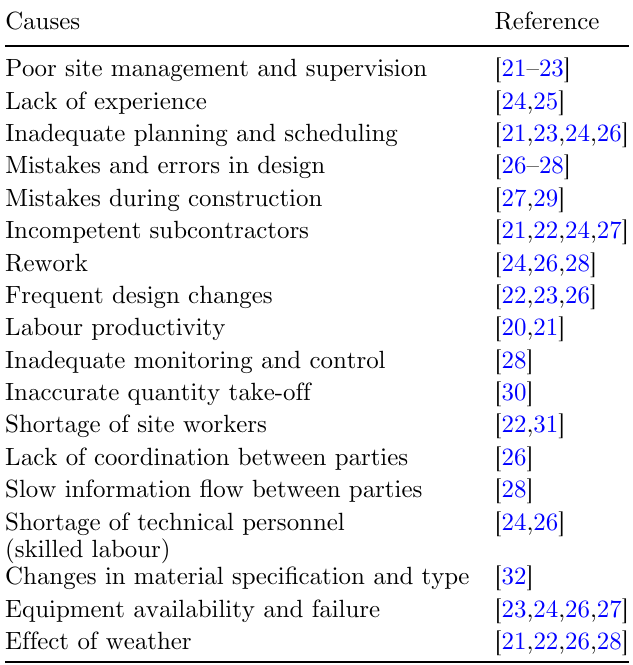
Table 1. Causes of construction